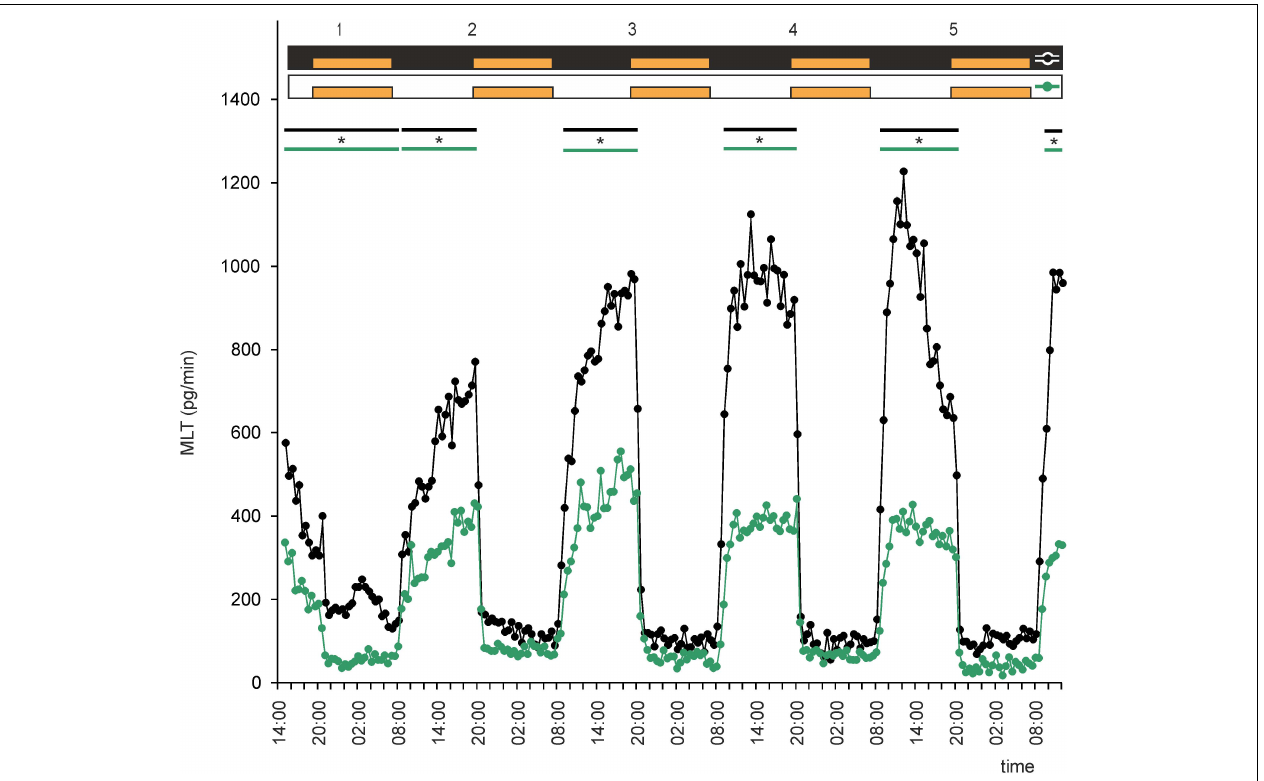
FIGURE 6 | Secretion (means, n = 4) of MLT by goose pineal organs incubated under continuous darkness (black line with circles) and continuous light (green line with circles) for 5 days and treated with NE during subjective nights. Orange bars indicate periods of NE treatment. Parallel lines with asterisks show periods, when the means differ significantly ( p < 0.05) between